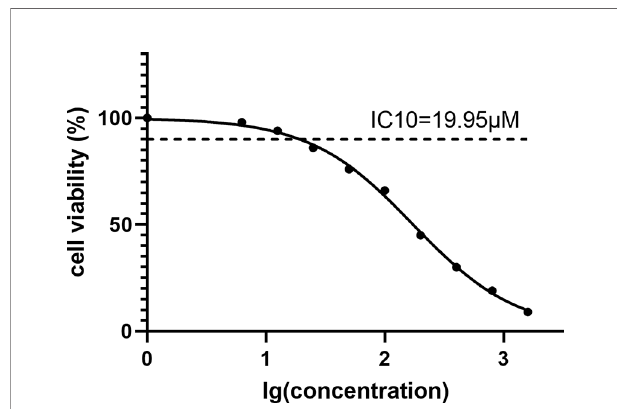
FIGURE 1 | Growth inhibition perifosine dose – response curve in C6 cells. The MTT assay was used to measure cell viability, and the 10% maximum inhibitory concentration of perifosine was 19.95 m M. Survival rate =